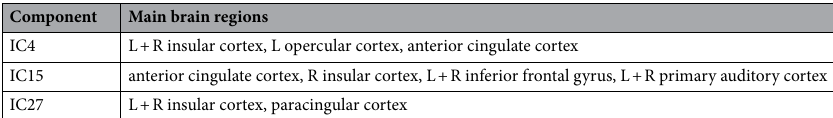
Table 1. Description of the selected independent components (ICs). R, right; L,